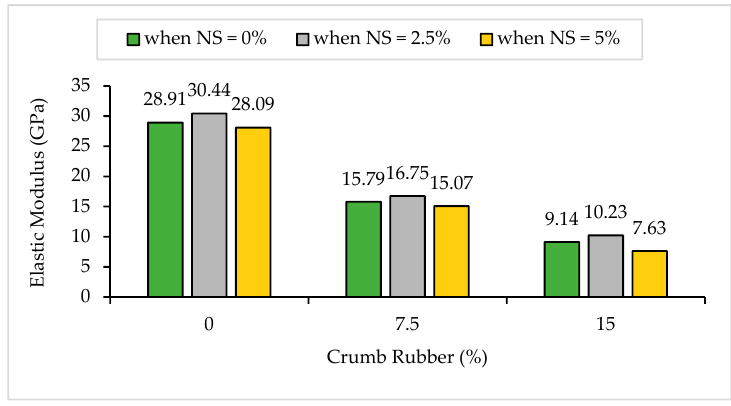
Figure 9. Modulus of Elasticity of NS-CRM mixes at 28 days.